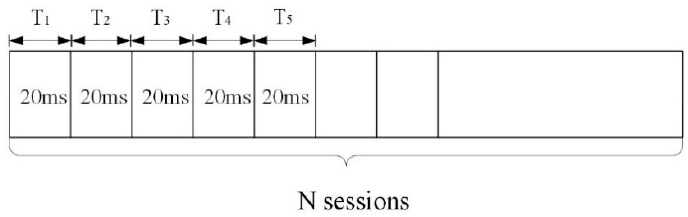
Figure 7. Computing session of the energy distribution of different overvoltage signals.